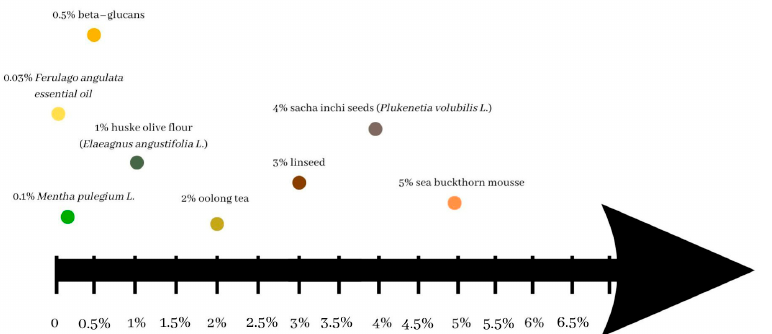
Figure 2. Maximum % of plant additive and positive overall acceptability (taste, odour and appear- ance) in the yoghurts.